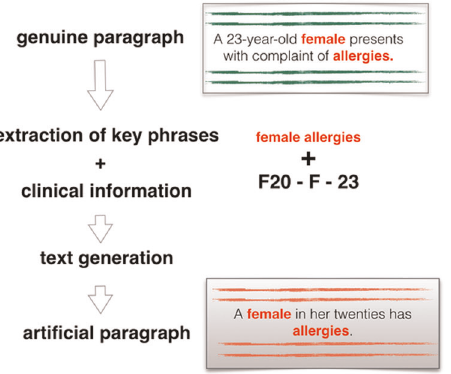
Fig. 1 Overview of the text generation procedure. Key phrases are extracted from paragraphs in the original data (genuine paragraph), and combined with clinical information (ICD-10 diagnosis code, gender and age). This is used in our text generation model, producing an arti fi cial paragraph.